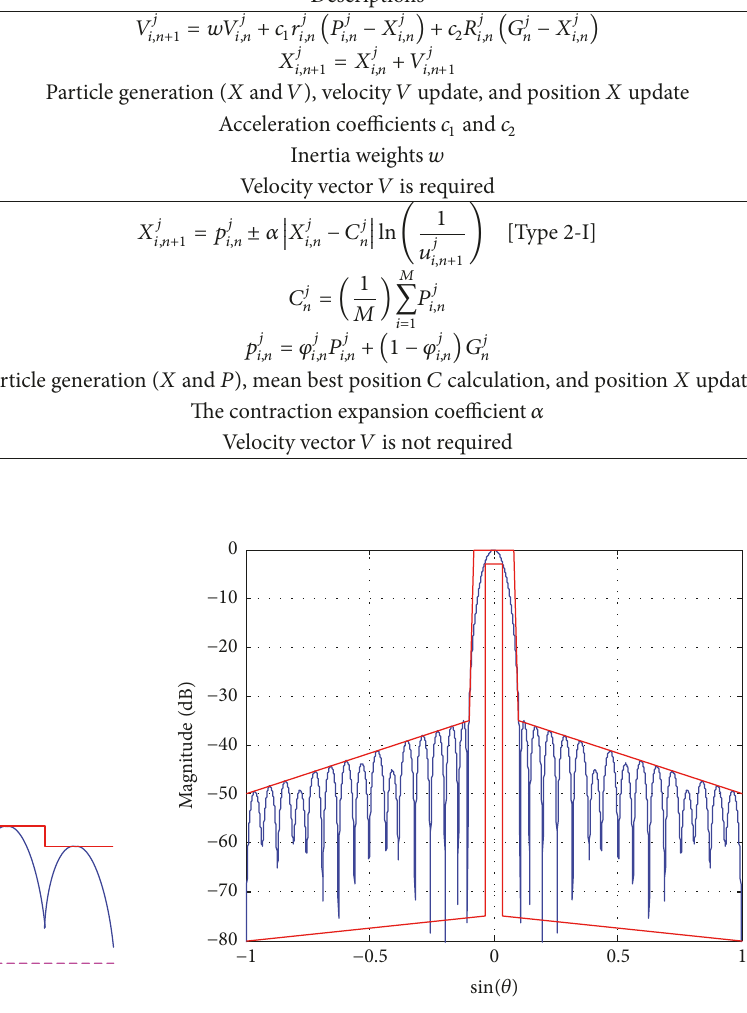
Figure 5: Antenna pattern synthesis simulation for parameter